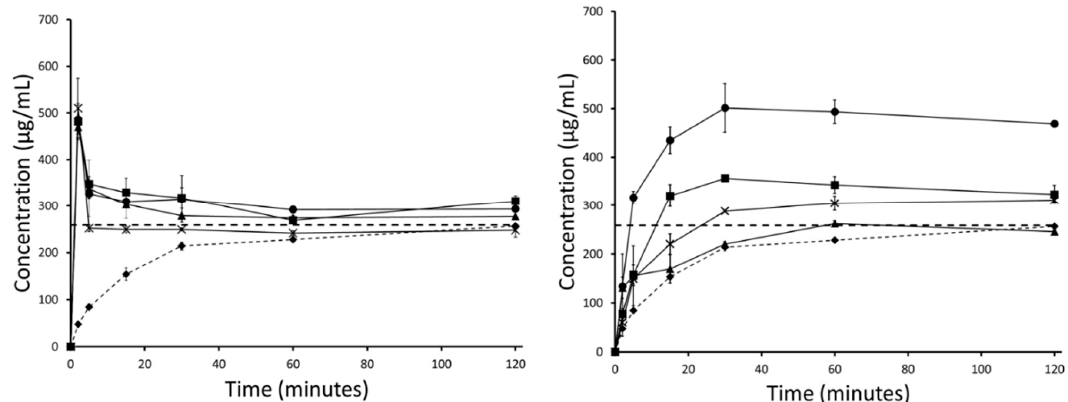
Figure 9. FaSSIF mini-dissolution curves for haloperidol loaded silica (left) and haloperidol HME formulation (right) showing crystalline haloperidol ( ), unstressed haloperidol formulation ( ● ), and stressed haloperidol formulations at 30 ( ▪ ), 60 (X), and 90 ( ) days.